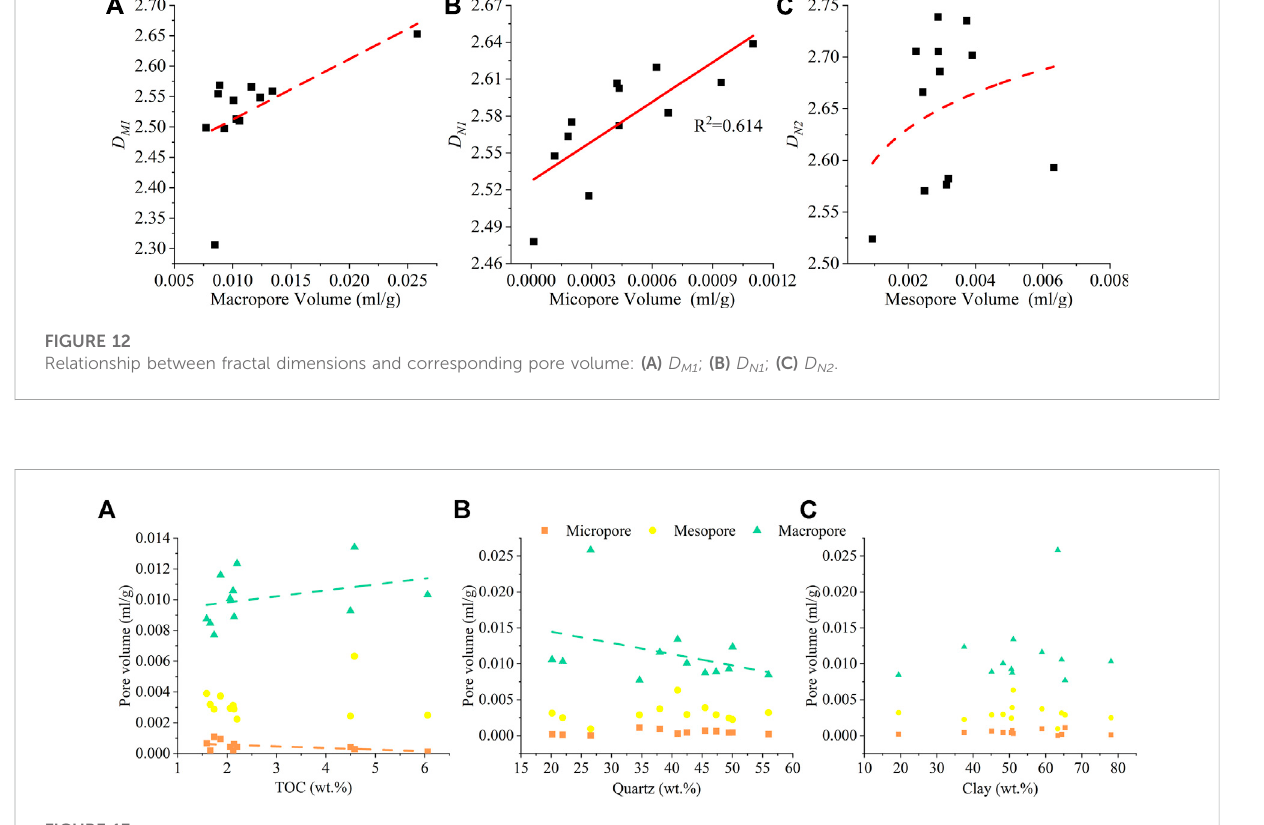
FIGURE 13 Relationship between PV and compositions of transitional shale: (A) TOC; (B) Quartz; (C)